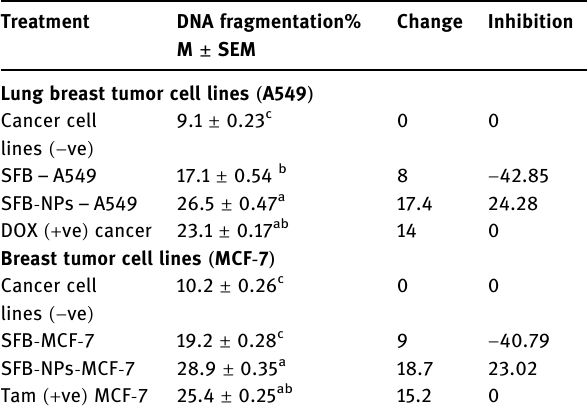
Table 3: DNA fragmentation detected in lung & breast cancer cell lines treated with SFB, SFB - NPs, DOX, and Tam Treatment